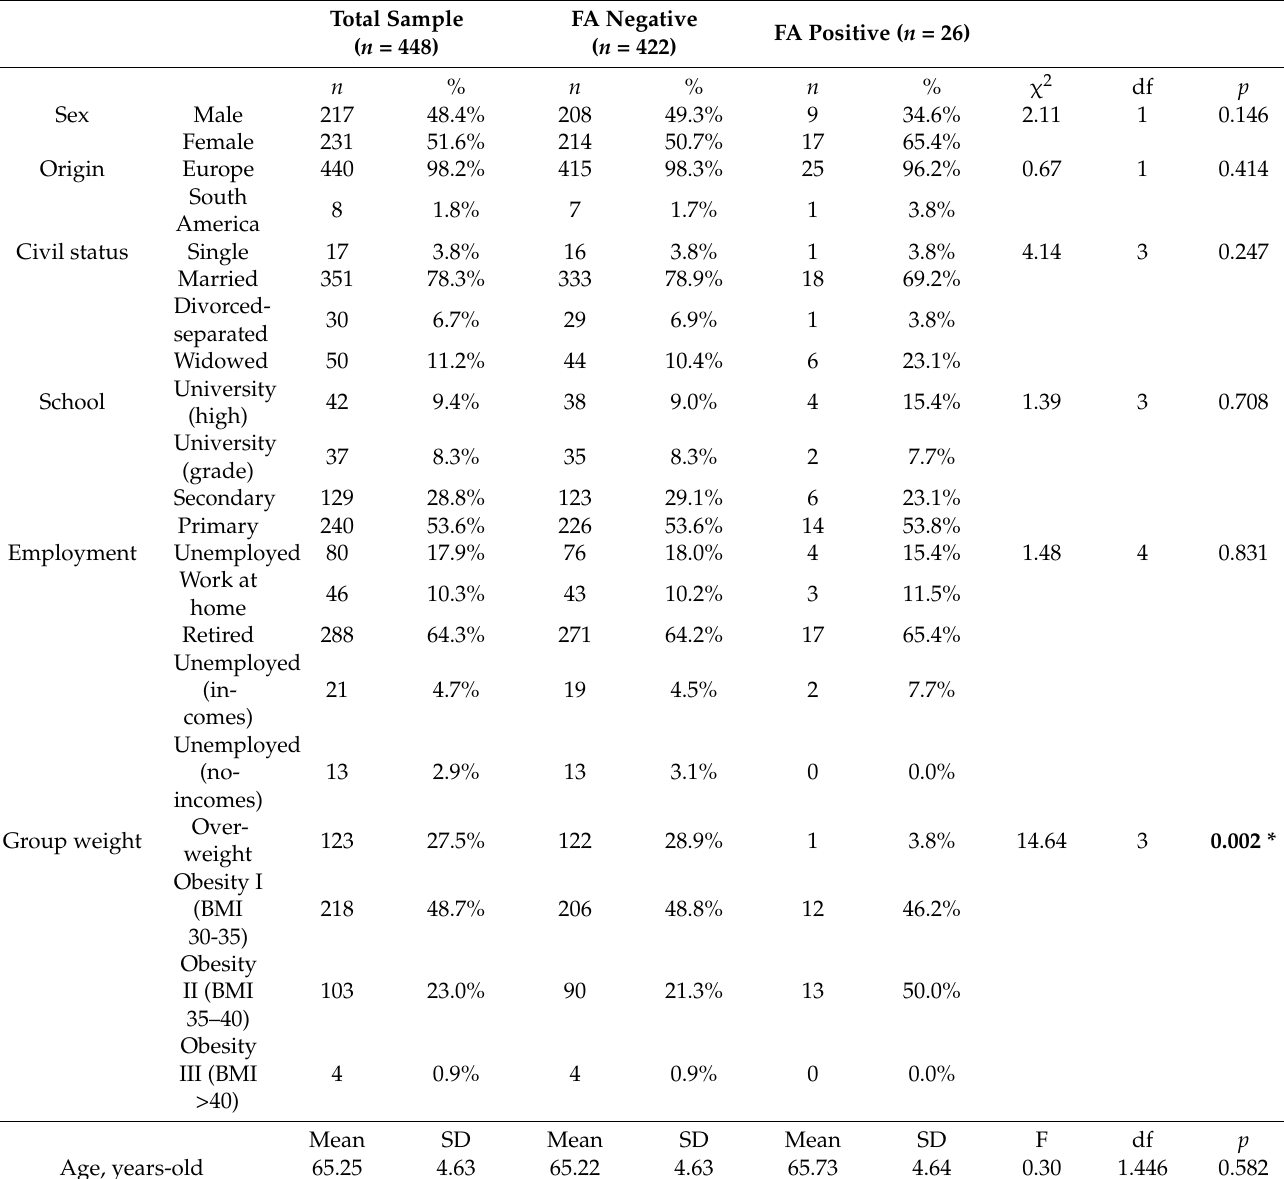
Table 1. Descriptive for the sample at